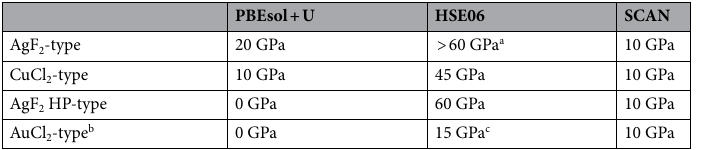
Table 1. Pressure of metallization for different polymorphs of AgCl 2 . a Although transformed into chains similar to CuCl 2 -type, the polymorph retains residual magnetic moment and non-zero band gap at the maximal studied pressure of 60 GPa. Magnetic coupling is FM intra-chain and AFM inter-chain. b Reopening of band gap occurs at higher pressures—see text. c This polymorph is mixed-valent in HSE06 picture and is non-magnetic at 0